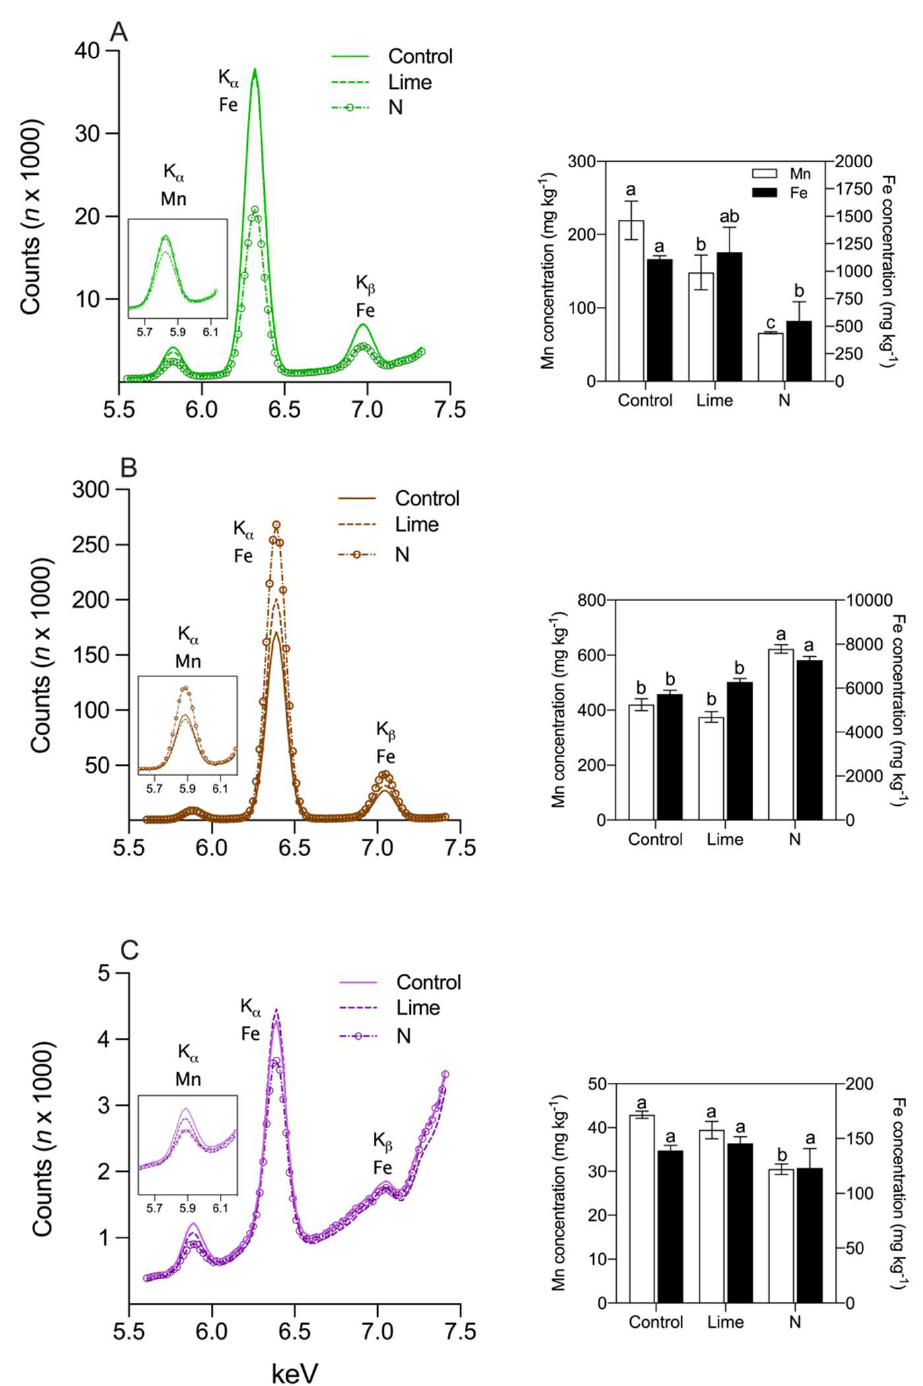
Figure 5. Fe and Mn concentrations in lentils grown in pots after 157 days after sowing. Curves show the X-ray fluorescence (XRF) spectra for Fe (K α and K β ) and Mn (K α ) in: ( A ) shoots; ( B ) roots, and ( C ) grains. The bar graphs beside the curves indicate the calculated concentrations of Fe and Mn derived from the fluorescence spectra for each plant organ. Small letters in the concentration graphs indicate significant differences among treatments after Tukey’s test ( p < 0.05).